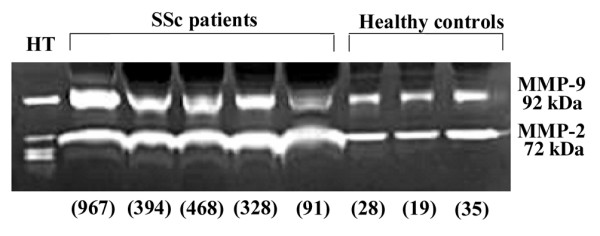
Gelatinase activity of matrix metalloproteinase (MMP)-2 (72 kDa) and MMP-9 (92 kDa) in sera of patients with systemic sclerosis (SSc) and healthy controls. Sera (0.5 μl) from 20 patients with SSc and 10 healthy controls were analyzed for their MMP-2 and MMP-9 activities by gel zymography. As a positive control, supernatants from cultured HT1080 cell lines (HT) stimulated with 10 μg/ml of concanavalin A were used. Numbers in parentheses are MMP-9 concentrations (ng/ml) determined by ELISA. The figure shows representative results for serum samples from the two groups.